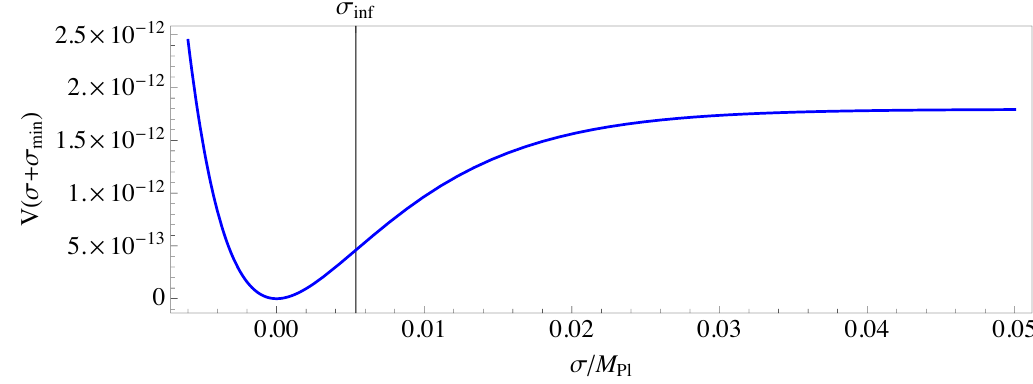
and with the minimum shifted Pl